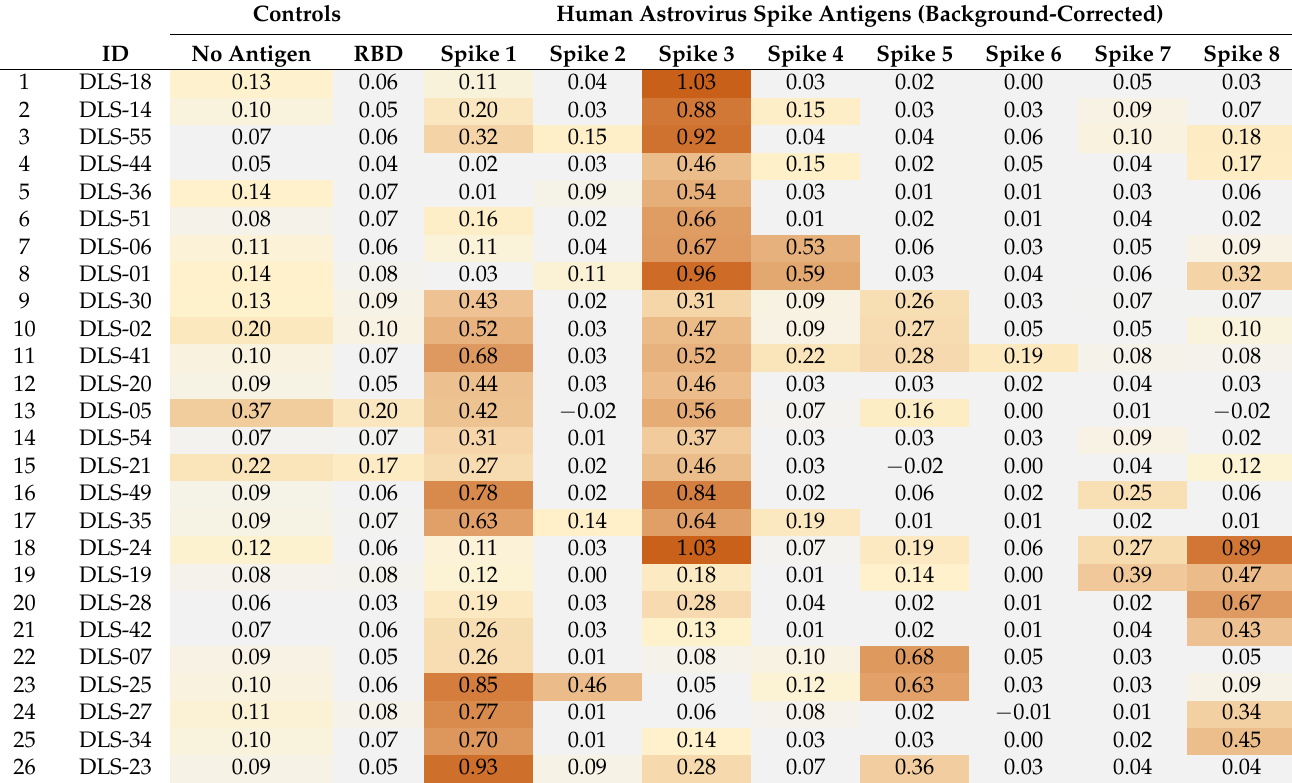
Figure 4. Human plasma IgG reactivity to human astrovirus spike proteins. Data are displayed as swarm plots, with each dot representing the signal for one individual for the indicated antigen. For samples with the RBD antigen, each sample’s RBD reactivity signal was subtracted by the mean RBD reactivity signal (0.07 nm) to center samples around zero. The dashed line indicates four standard deviations above zero for the RBD samples (0.12 nm), and the printed percentages denote the number of samples above the line. For samples with the spike antigens, each sample’s spike reactivity signal was subtracted by its own RBD reactivity signal to generate a background-corrected signal. Table 4. Heat map of individual human plasma IgG reactivity to human astrovirus spike antigens.